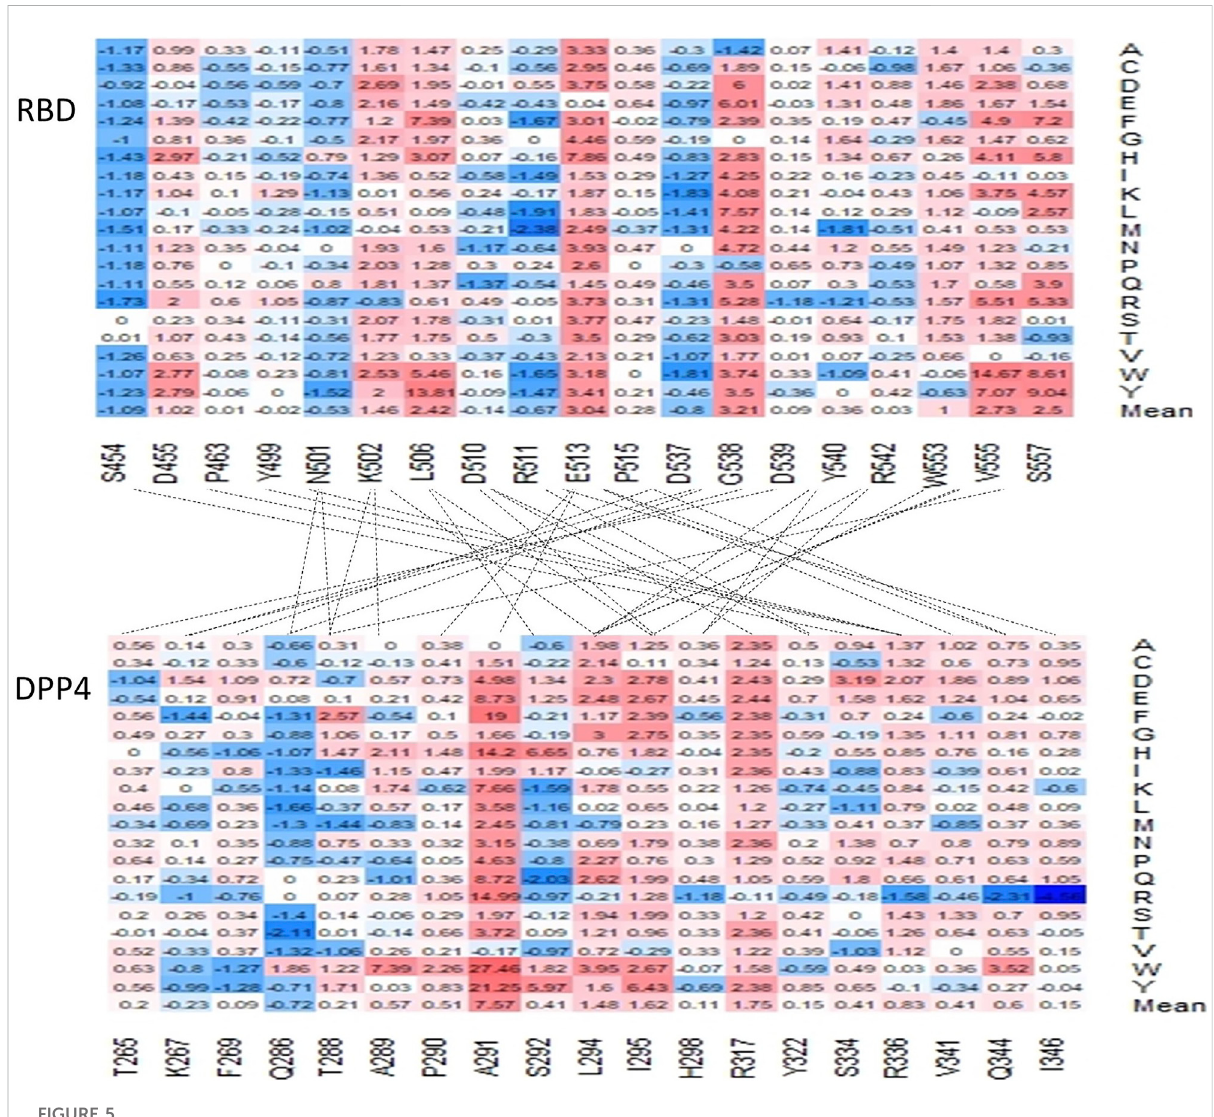
FIGURE 5 Chartsofthepredicted ΔΔΔ Gofresiduespredicted tointeractwithintheinterfaceoftheMERS-CoVSproteinandtheDPP4receptor.Thelines indicate which residues are predicted to contact another in the two